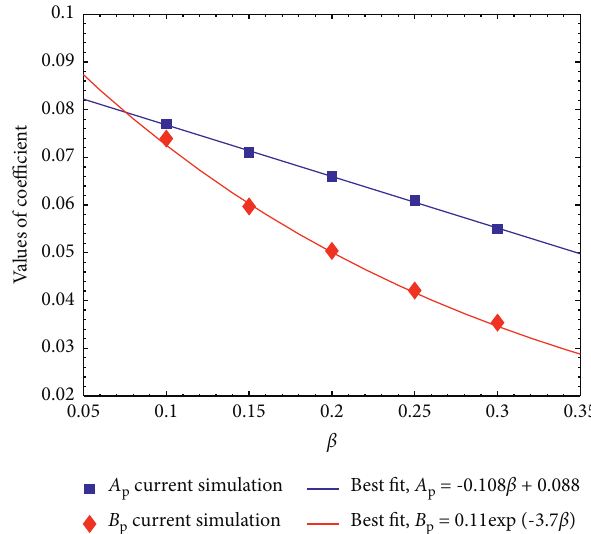
Figure 15: Values of A